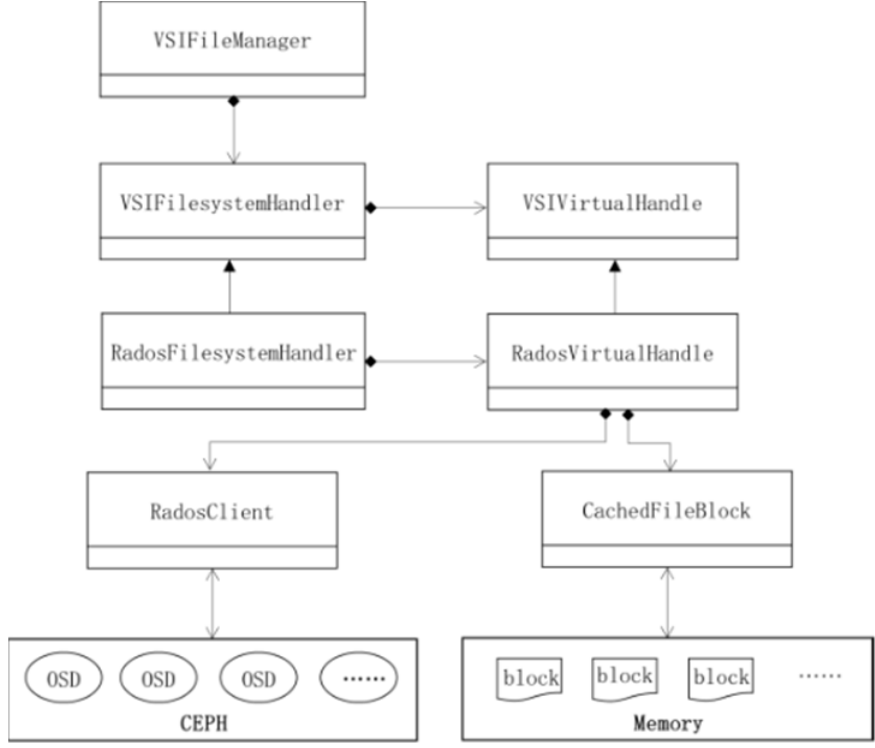
Figure 20. Detailed structure of /vsirados/ implementation.